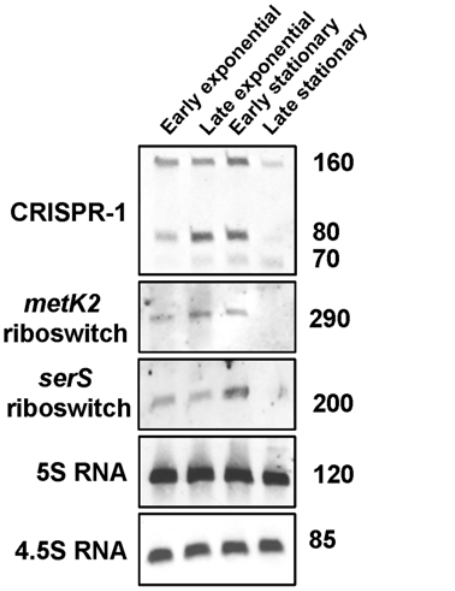
Figure 3. Northern blot verification of riboswitches and other small RNAs. Northern blots were performed using RNA isolated from strain MGAS2221 at 4 growth phases. The name of the candidate RNA molecules are shown to the left of each Northern. To the right of each Northern is the approximate size in nucleotides of the transcript/s. The 5S RNA served as a loading control.